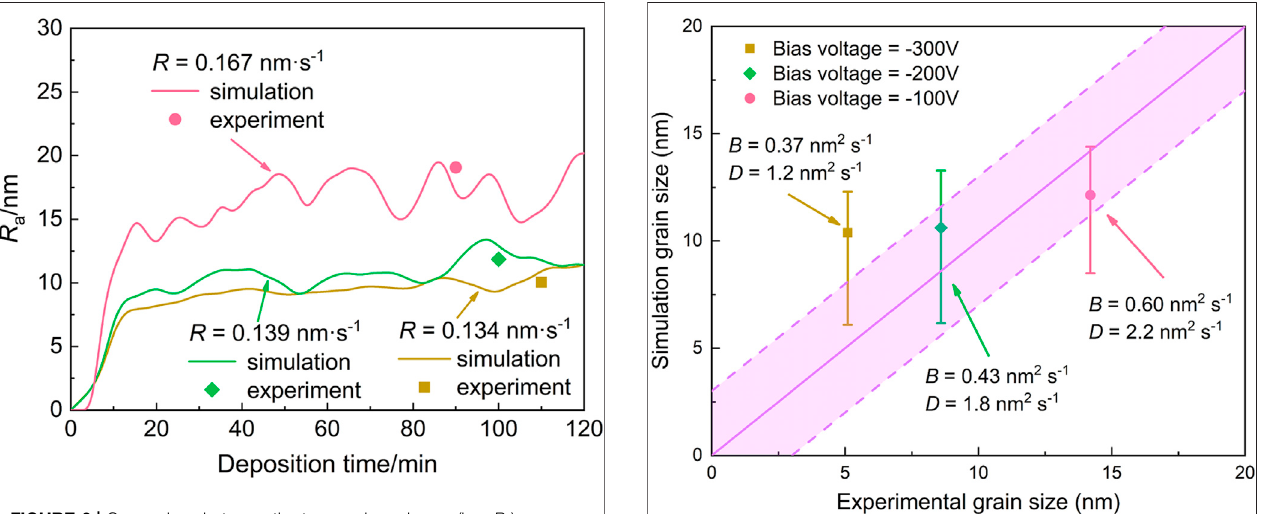
FIGURE 6 | Comparison between the temporal roughness (i.e., R a ) according to the phase- fi eld simulation for PVD and the experimental data of R a (Wang et al., 2015) for TiN coatings deposited with different deposition rates (i.e., R ).